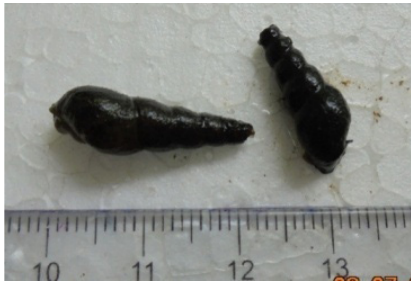
Figure 2: freshwater snail Melanoides sp . collected from sandy bottoms of Maha-Oya in Kegalle district.